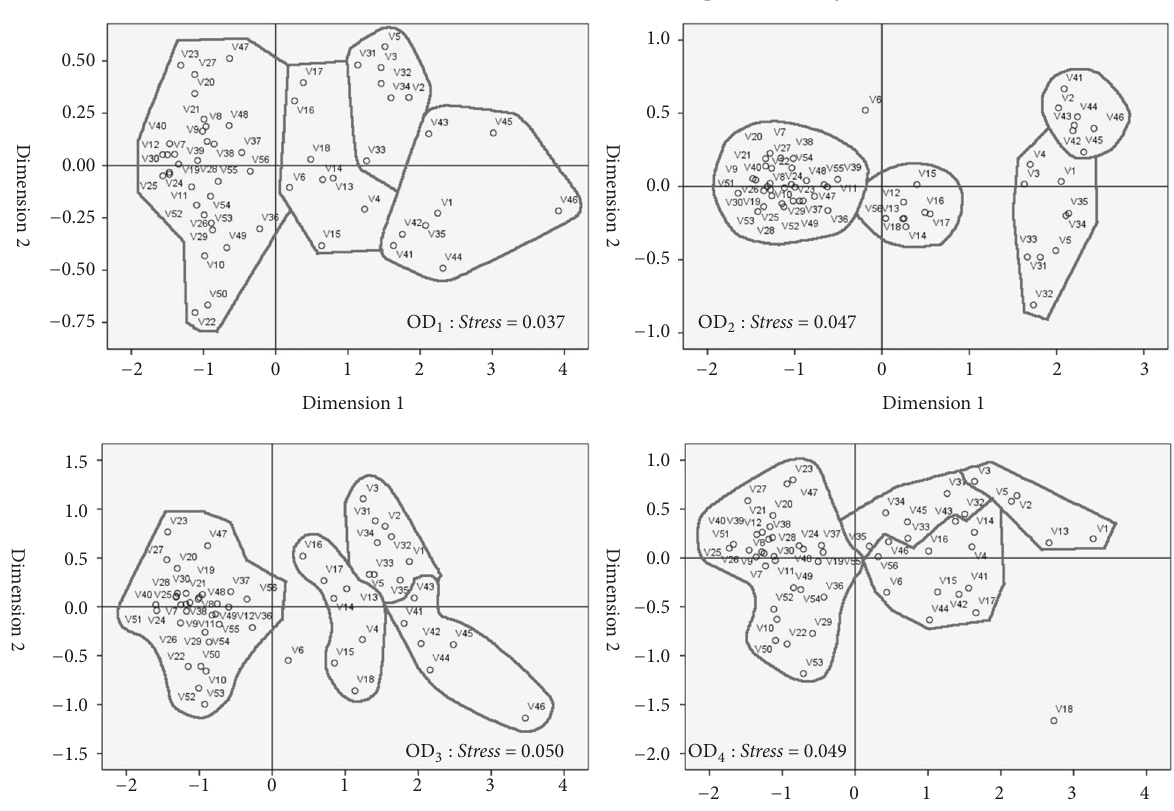
Figure 3: Road section selection based on qualitative